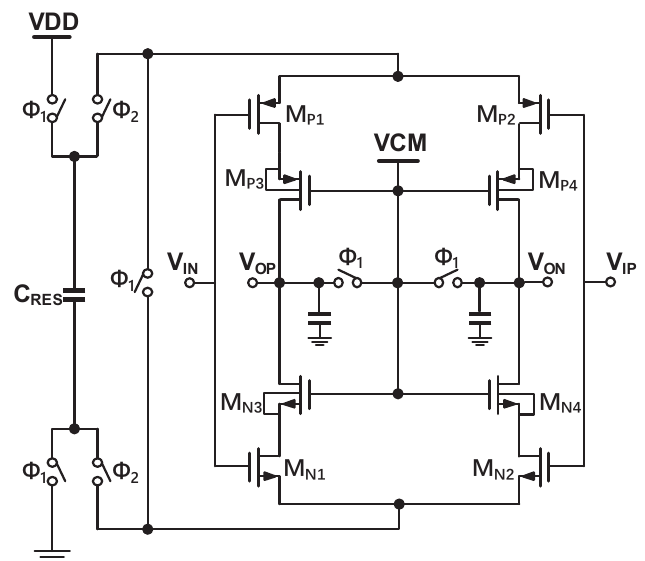
Figure 9. The proposed cascoded FIA.